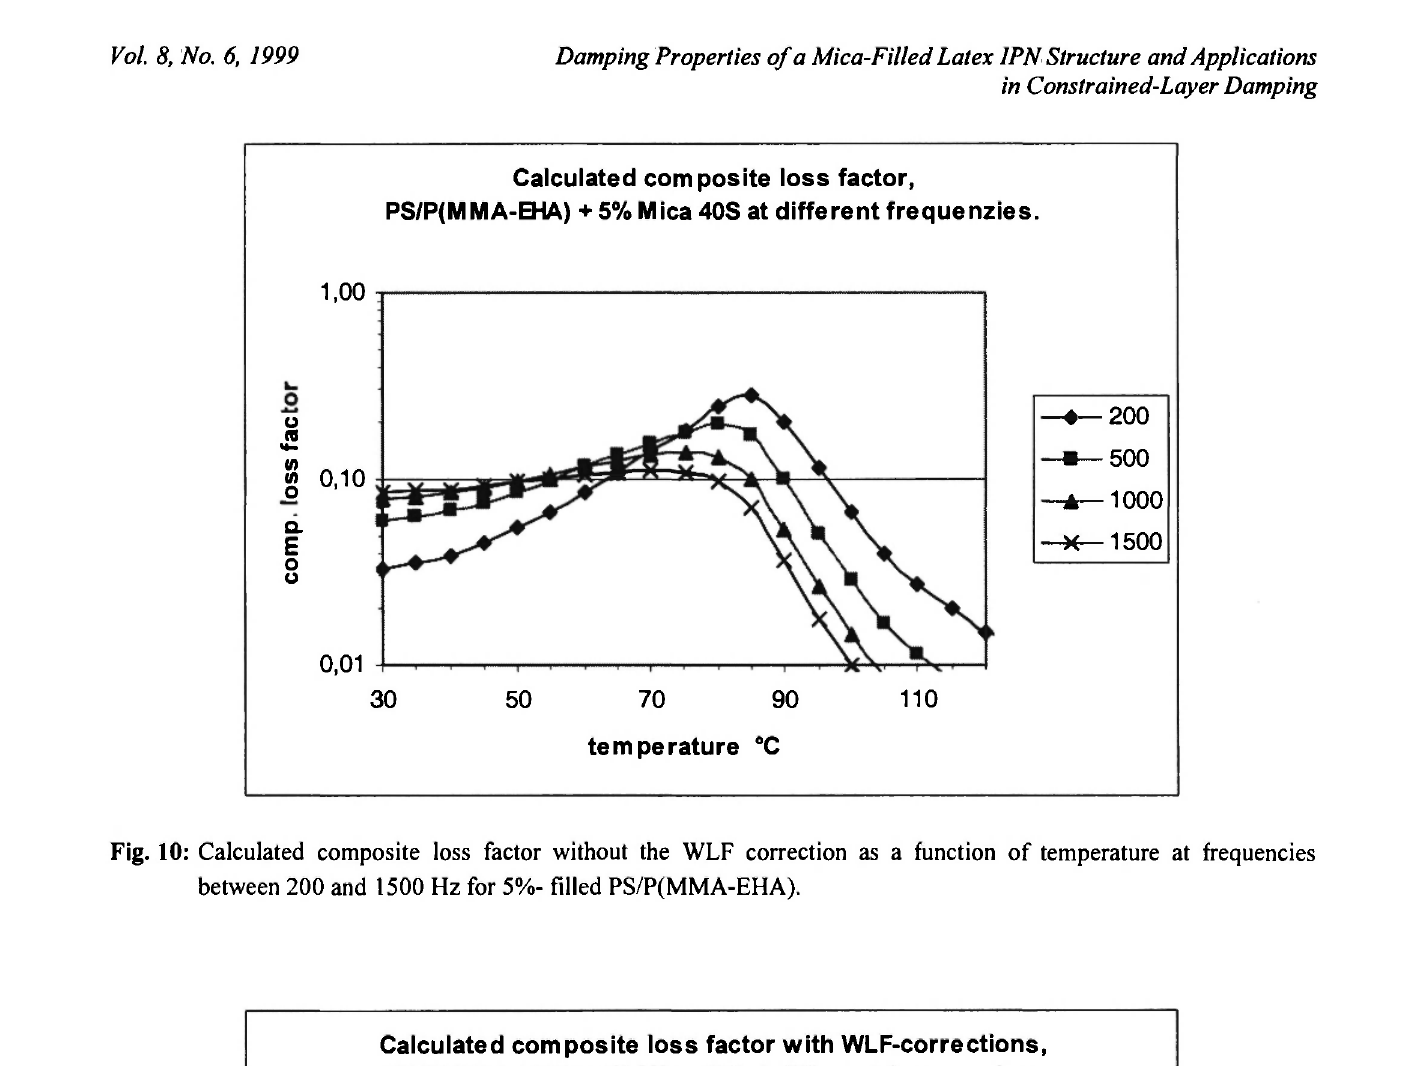
Fig. 10: Calculated composite loss factor without the WLF correction as a function of temperature at frequencies between 200 and 1500 Hz for 5%- filled PS/P(MMA-EHA).